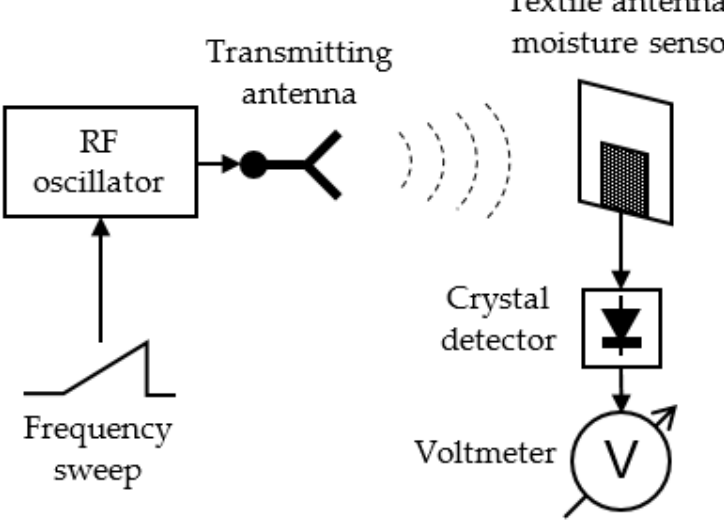
Figure 16. Textile antenna as moisture sensor, transmission mode setup [16].